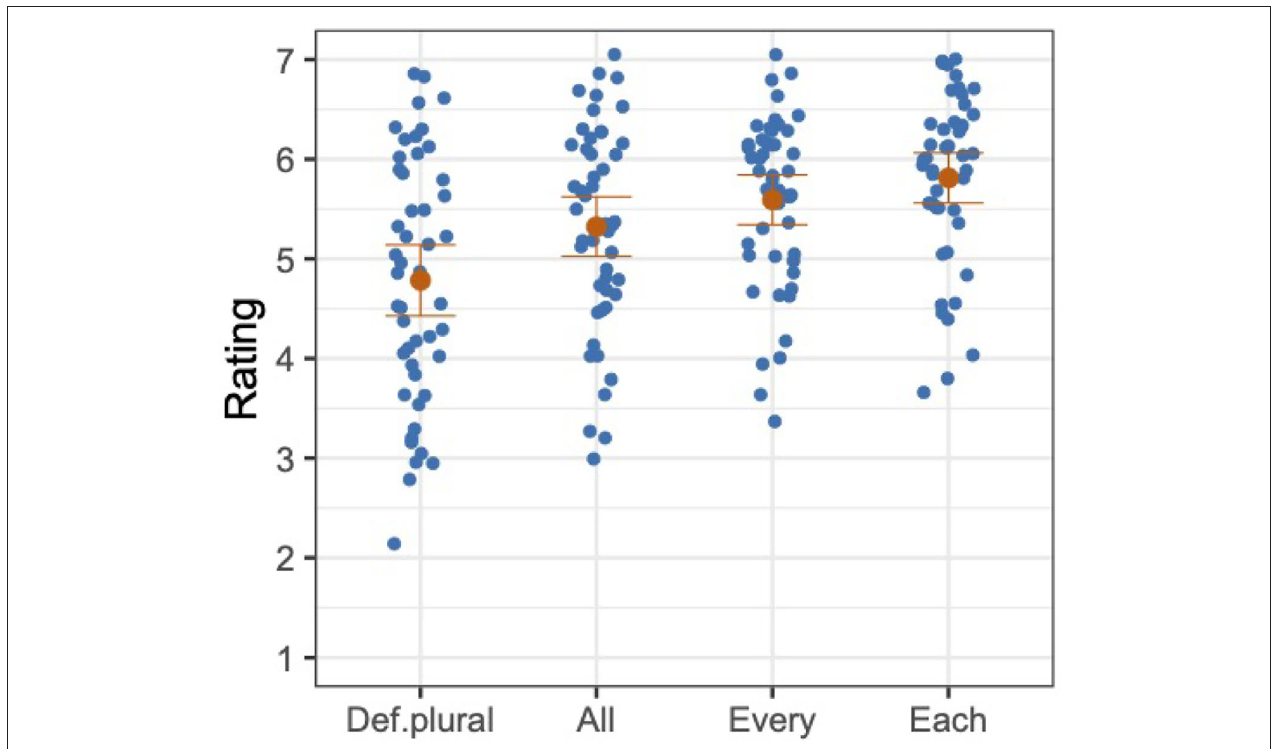
FIGURE 1 | Distributions of mean ratings of participants (in blue), and mean ratings across participants with standard errors (in orange), Experiment 1.